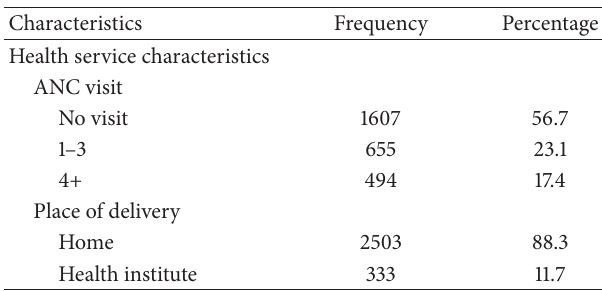
Table 1: Sociodemographic and other health related characteristics of children aged 6–23 months, Ethiopia,